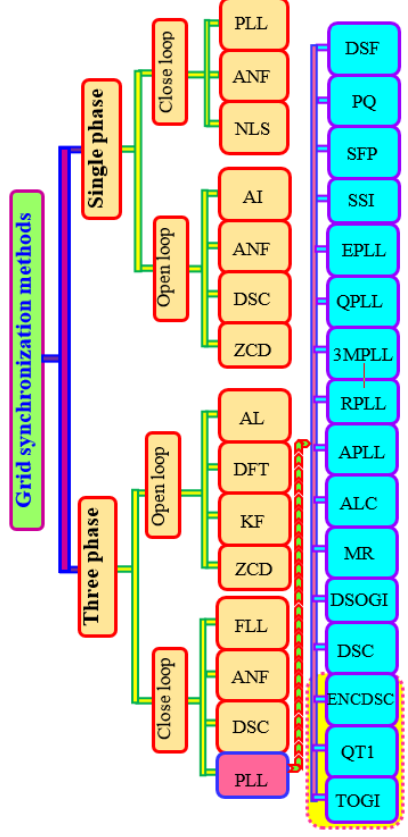
Figure 1. Overview on synchronization methods.